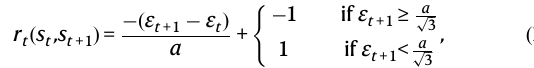
Fig. 2 | DRL training results. a , b The rolling mean (solid lines) and standard deviation(shadedareas)ofepisodereward,successrate,error,andepisodelength over 100 episodes showcase the training progress. The arrows indicate signi fi cant tipchangeswhichoccurredwhenthetipcrashed deeplyintothesubstrateandthe tip apex needed to be reshaped to perform manipulation with the baseline para- meters (see Methods) and the changes can be observed in the scan (see Supple- mentaryInformation). c Theprobabilityanatomisplacedatthenearestadsorption site to the target at a given error P ( x adatom = x nearest ∣ ε ) is calculated considering either onlyfccsitesor bothfccand hcpsites(seeMethodssection).With the error distribution of the 100 consecutive successful training episodes, we estimate the